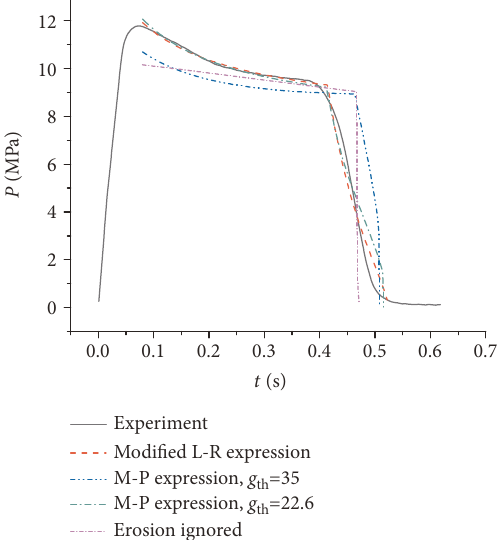
Figure 6: Computational and experimental P − t curves. In two di ff erent numerical cases using the Mukunda-Paul expression, K is maintained as